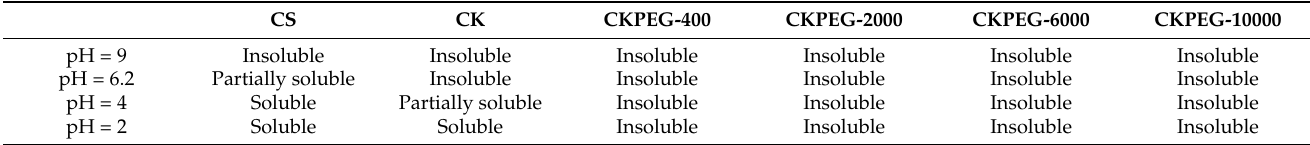
Table 4. Aqueous stability of CS and composite membranes using varying PEG Mw.